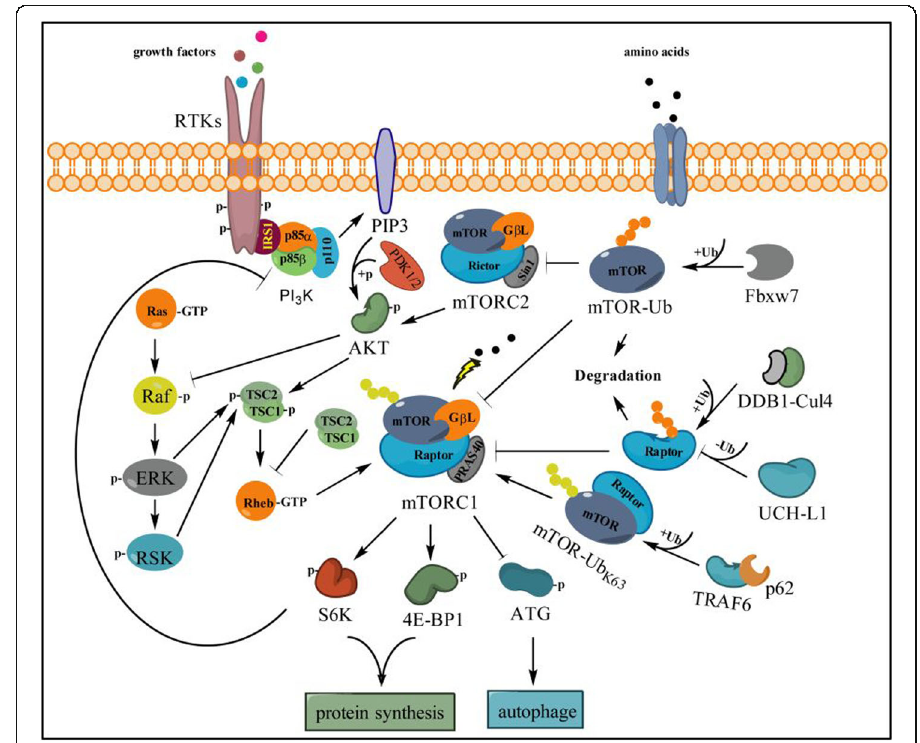
Fig. 3 Ubiquitination on mTOR signal affects the cross-talk between RAS-RAF-MEK and PI3K-AKT-mTOR pathways . TSC2 and mTORC1 as the downstream sensor receive many inputs from both RAS-RAF-ERK and PI3K-AKT signaling to activate S6K and 4E-BP1 for mRNA translation and protein synthesis, as well for inhibition of autophagy. Meanwhile, activated mTORC1 can enhance the RAF-ERK signaling through feedback inhibition of PI3K but not of AKT or mTORC2. In this pathway, Fbxw7 is responsible for recognizing mTOR and executing the ubiquitination (K48-Ub chains) for further proteasome degradation to reduce the activity of mTORC1 and mTORC2. Upon the stimulation of amino acid, K63-linked ubiquitin chains on mTOR are essential for activation of mTORC1, which is triggered by TRAF6 with the assistance of p62 and adaptor protein Raptor. However, Raptor, an essential component of mTORC1, can be poly- ubiquitinated and deubiquitinated by the DDB1-Cul4 complex and UCH-L1, respectively, thereby impairing the activity of mTORC1 and downstream